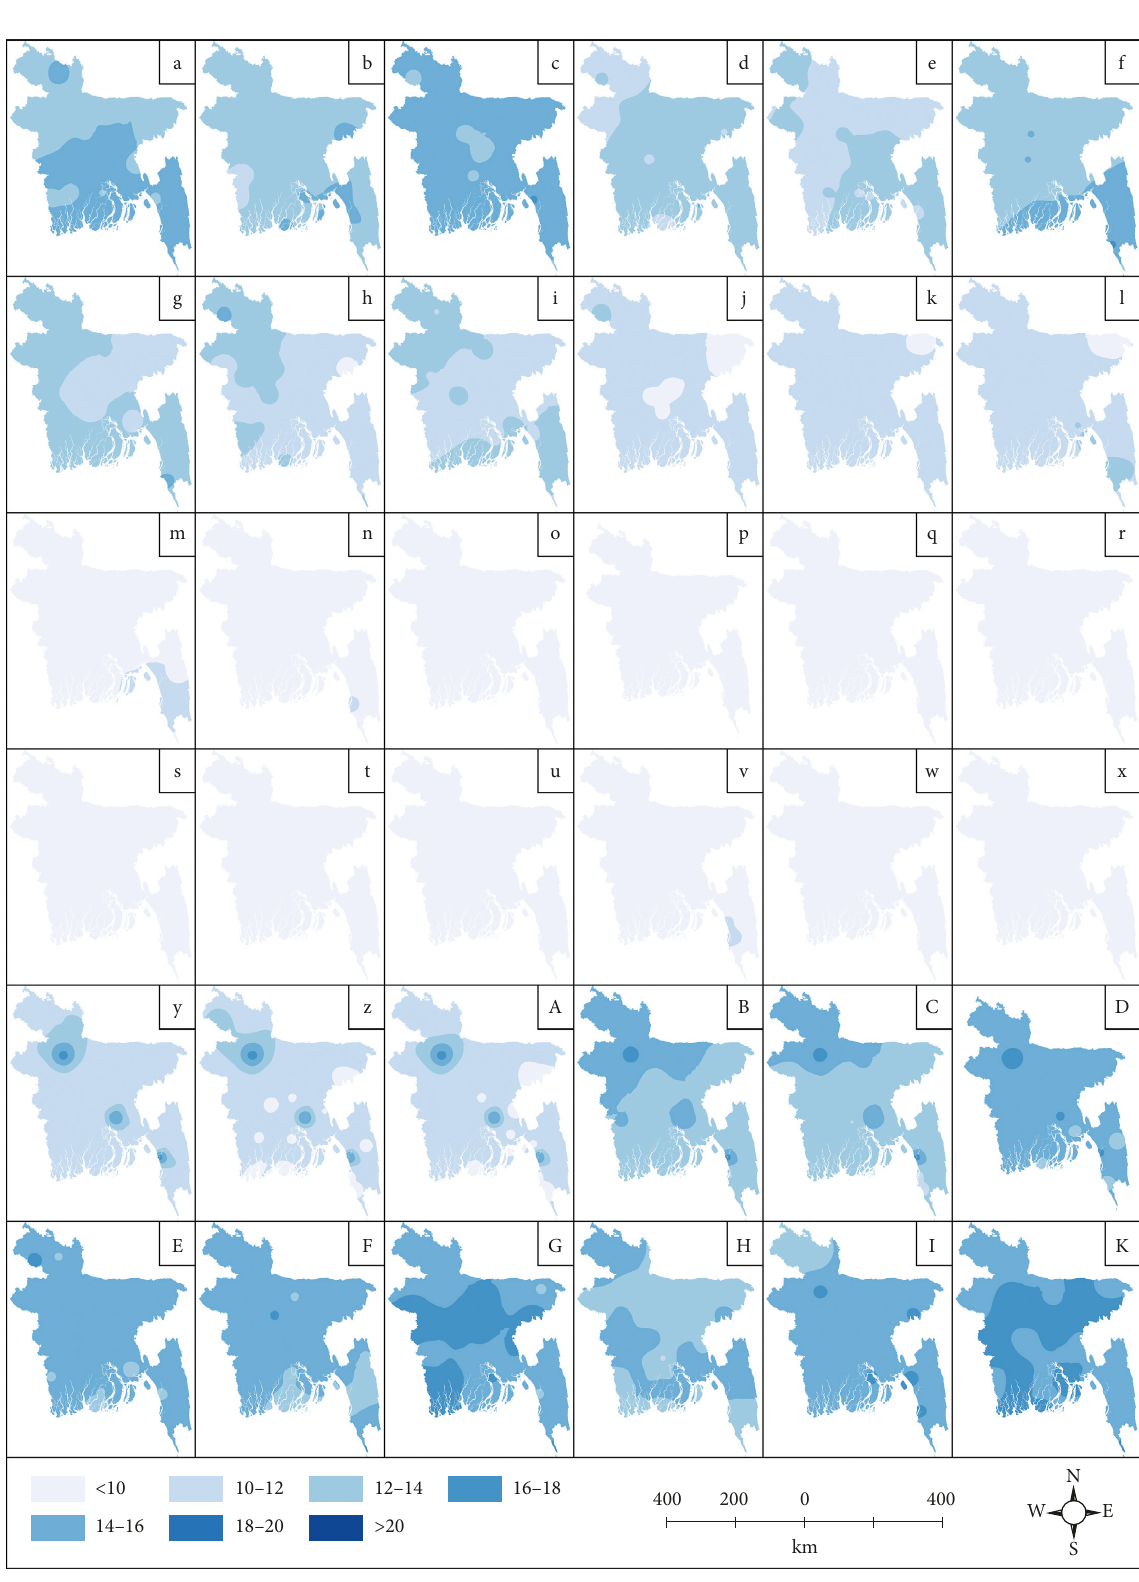
Figure 8: Decadal analysis of the two-month PCI (a, b, c) JF; (d, e, f) FM; (g, h, i) MA; (j, k, l) AM; (m, n, o) MJ; (p, q, r) JJ; (s, t, u) JA; (v, w, x) AS; (y, z, A) SO; (B, C, D) ON; (E, F, G) ND; (H, I, J) DJ for the representative decades 1980–1989, 1990–1999, and 2000–2011 over